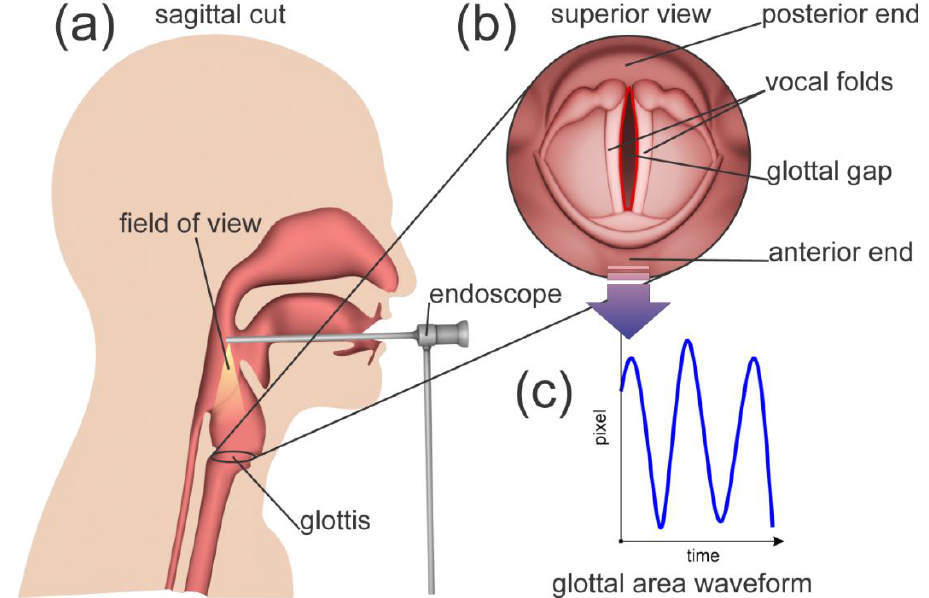
Figure 1. ( a ) Recording of the vocal fold oscillations via a rigid endoscope being attached to a high-speed camera. ( b ) Superior view of the vocal folds as seen with the endoscope. ( c ) Computed glottal area waveform (GAW): amount of registered pixels in the glottis over time.